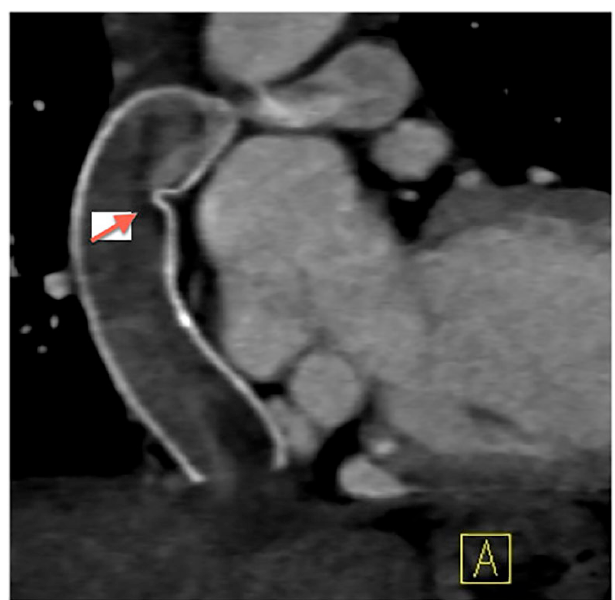
Fig. 3B - Material deposited in the extracardiac conduit - Chest angiotomography image (long axis) performed 6 months after total cavopulmonary connection with extracardiac conduit. Patient who was using ASA developed with conduit kinking with deposit of large amount of material. Long axis cuts with material deposited in the conduit bending site (arrow)